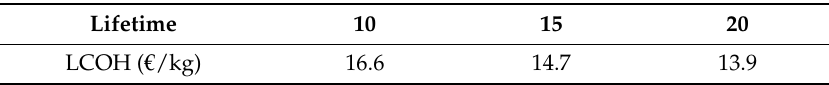
Table 6. Summary of the main LCC